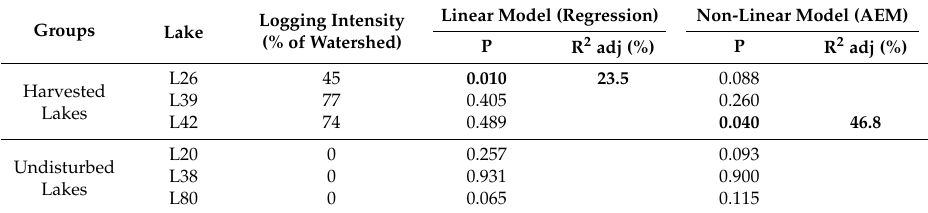
Table 4. Modelling of the temporal patterns for the zooplankton groups (Cyclopoida, Calanoida, Rotifera, and Cladocera) for each harvested and undisturbed lake from 1991 to 2003. Bold values indicated significant long-term temporal pattern of variation. AEM: Assymetric Eigenvector Map. Linear Model (Regression) Non-Linear Model (AEM) Groups Lake Logging Intensity (% of Watershed) P R 2 adj (%) P R 2 adj (%) Harvested Lakes